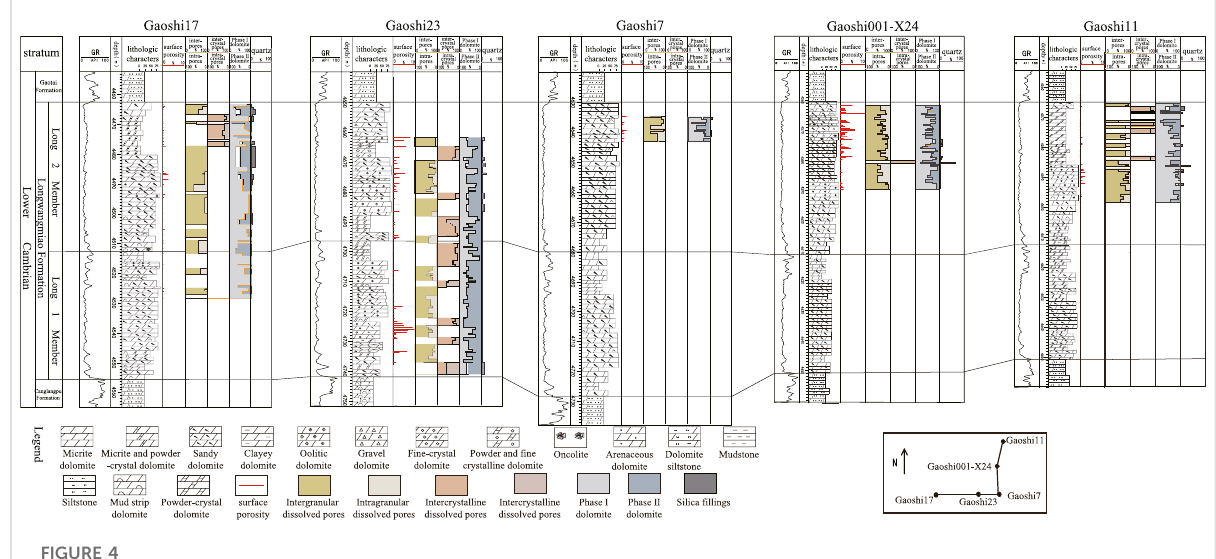
FIGURE 4 Comparison of pore development characteristics of the Longwangmiao Formation in the study area through Wells Gaoshi 17-Gaoshi 23- Gaoshi 7-Gaoshi 001-X24 -Gaoshi 11.